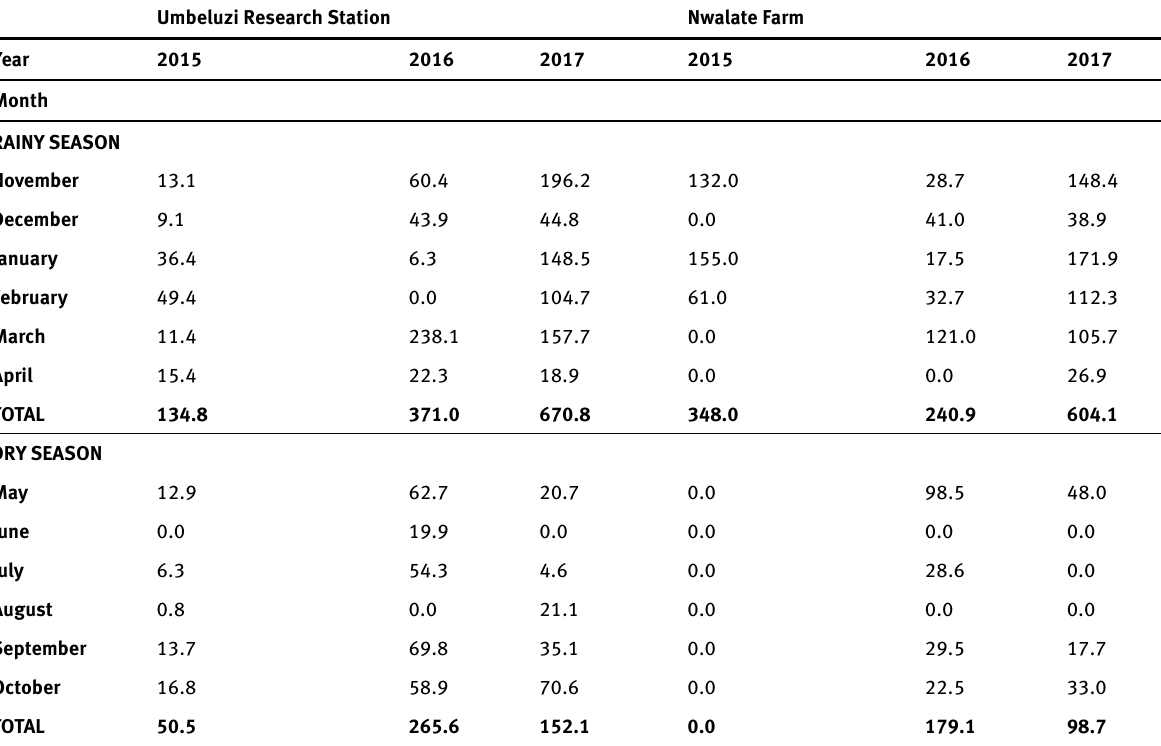
Table 2: Rainfall (mm) received at Umbeluzi Research Station and Nwalate Farm during the rainy and dry seasons in 2015, 2016 and 2017 Umbeluzi Research